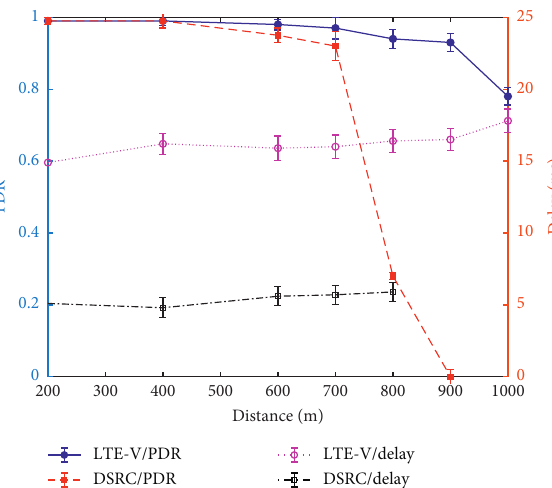
Figure 11: Valid communication testing